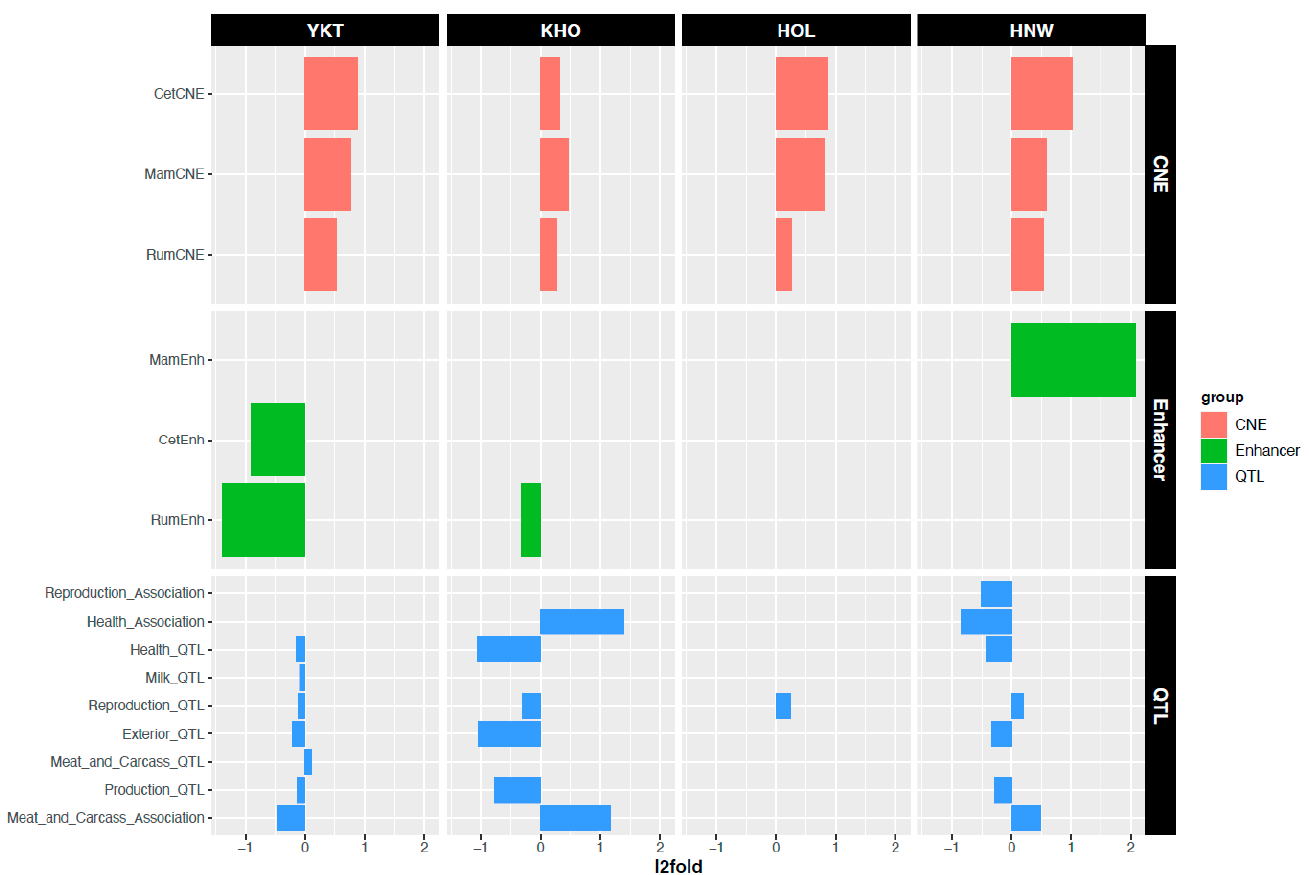
Figure 2. Breed-specific CNVR overlapping CNEs, enhancers, and QTLs. Abbreviations are as follows: YKT—Yakut, KHO—Kholmogory, HOL—Holstein, HNW—Hanwoo, CNE—conserved non-coding elements.